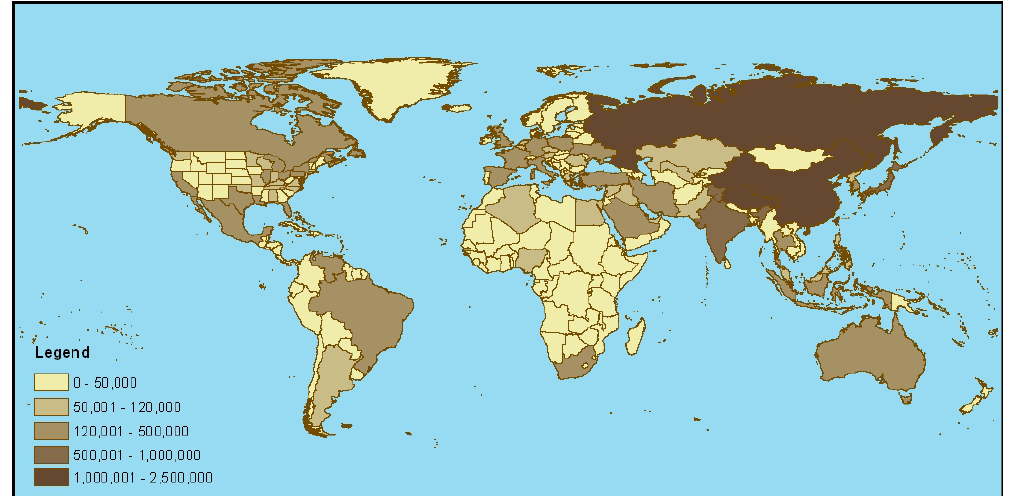
emissions data in thousand tonnes, 2